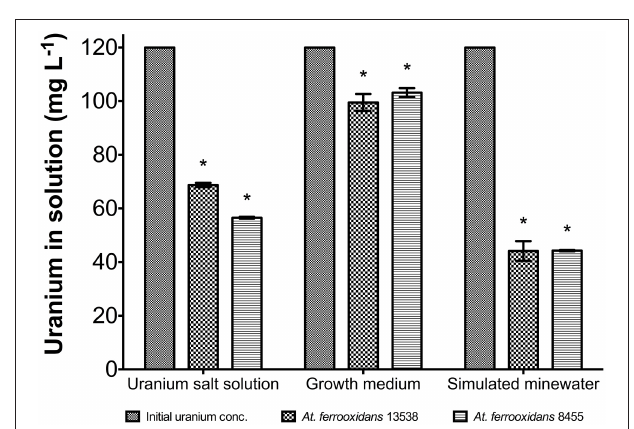
FIGURE 5 | Amount of uranium removed from uranyl nitrate, growth media spiked with U(VI) and simulated mine water spiked with U(VI) solutions by At. ferrooxidans strains 8455 and 13538. A higher concentration of U(VI) was removed from simulated mine water solution. Data labeled with * indicate significant different results.